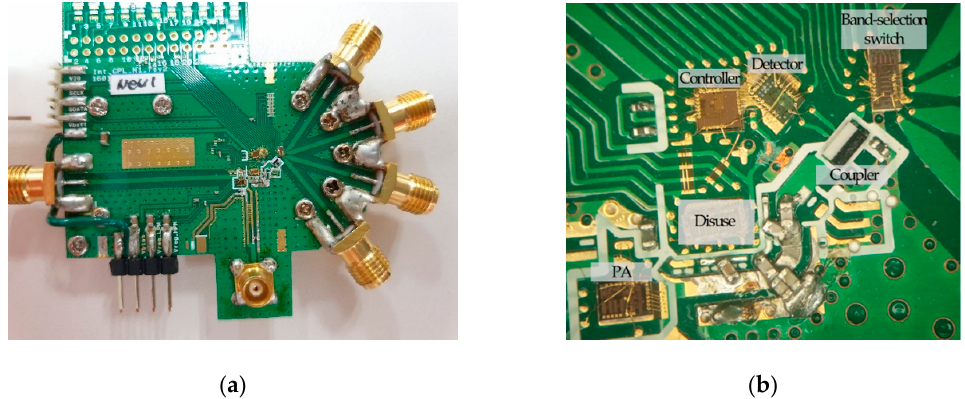
Figure 8. Photograph of: ( a ) assembled module; ( b ) enlarged core area with names of each component.